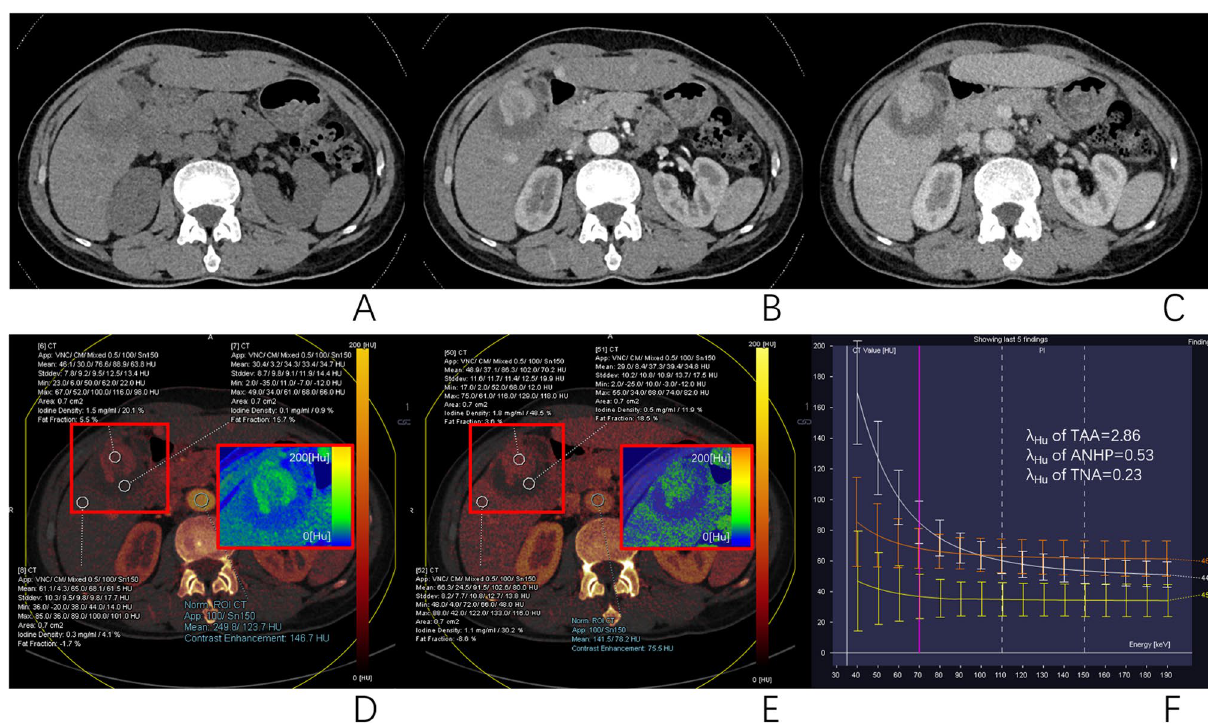
Figure 3. DECT images of a 58-year-old man with HCC undergoing DEM-TACE 6 weeks ago, showed that no lipiodol deposition in the original tumor lesions, but TAA and TNA were present. The right hepatic lobe showed a low-attenuation lesion on unenhanced CT image ( A ), significant enhancement at arterial phase ( B ), and persistent enhancement at the portal venous phase( C ). TNA had no enhancement. ROIs of TAA, ANHP, and TNA placed on arterial and portal iodine map ( D and E ) showed IC and NIC of TAA to be 1.5 mg/ml and 20.1% at arterial phase and 1.8 mg/ml and 48.5% at portal venous phase, respectively. The IC and NIC of ANHP was 0.3 mg/ml and 4.1% at arterial phase, and 1.1 mg/ml and 30.2% at portal venous phase, respectively. The IC and NIC of TNA was 0.1 mg/ml and 0.9% at arterial phase and 0.5 mg/ml and 11.9% at portal venous